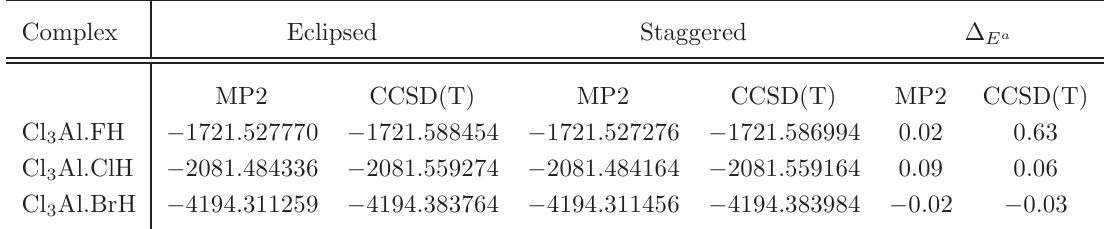
Table 1 MP2 and CCSD(T) total energies ET (a.u.) and relative energies ΔE (kcal/mol) (between the two conformations) of the Cl AlXH electron complexes (X = F, Cl, and Br). 3 Complex Eclipsed